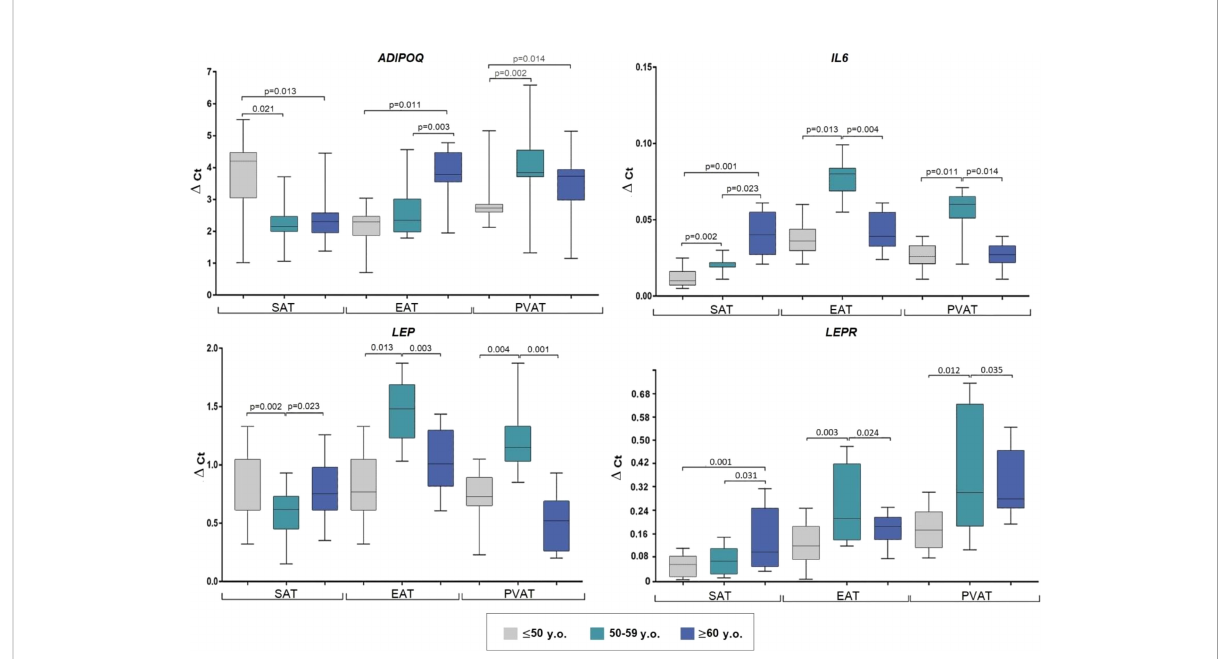
FIGURE 2 Adipocytokine gene expression in the adipocytes collected from adipose tissue based on the age of coronary artery patients. Data are presented in Me (Q1; Q3). SAT, subcutaneous adipose tissue; EAT, epicardial adipose tissue; PVAT, perivascular adipose tissue; p, level of statistical signi fi cance; sOB-R, soluble leptin receptor; IL6, interleukin